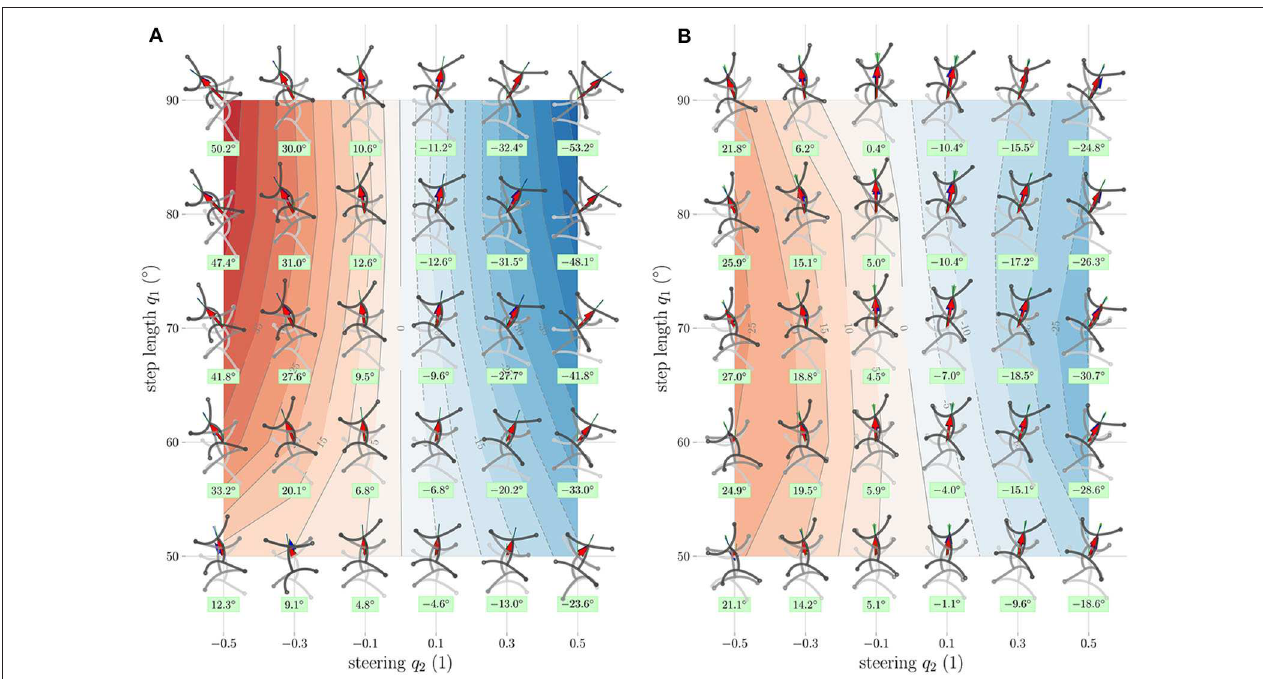
FIGURE 7 | Resulting experimental gaits according to the gait law in Equation (14) for a variation of step length and steering factor. The rows each have a constant step length q 1 and the columns a constant steering factor q 2 . Each frame shows the resulting motion of one cycle with the pattern corresponding to ( q 1 , q 2 ). Below each frame, the rotation per cycle in degrees 1ε is stated. The heat map in the background shows the polynomial fit of 1ε . The bold red vector pointing from the initial position of each individual gait to its end position is called [ 1 x 1 y ] ⊤ . (A) Simulation (89, 10, 5.9) and (B) experiment.